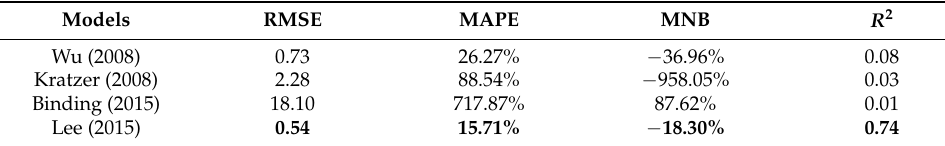
Table 2. Quantitative evaluation of the inversion models for Z SD .